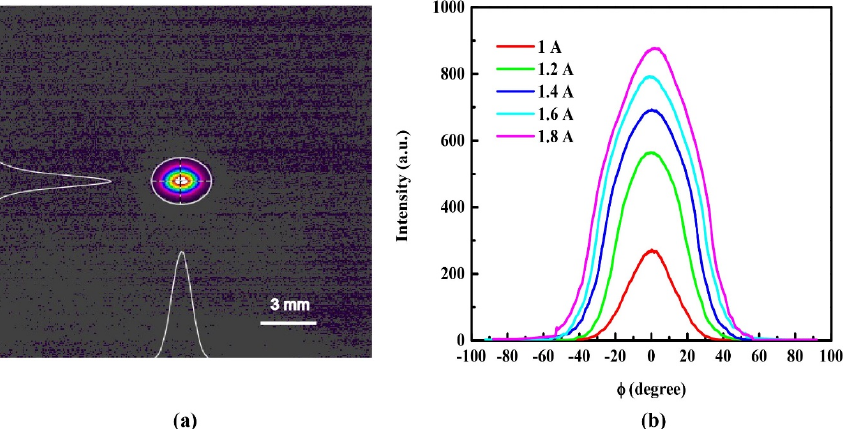
Table A1. The calculated beam M 2 in the x -axis and y -axis direction are 1.146 and 1.045.